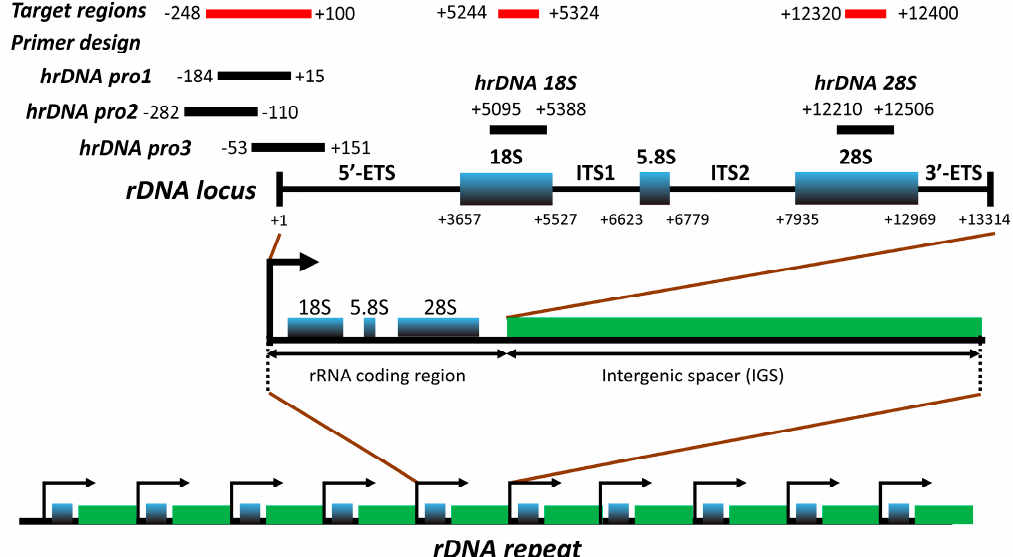
Figure 1. Location of the target regions selected for sequence analysis within the rDNA locus. Base positions are relative to transcription start site ( + 1) of the rRNA gene (rDNA). Each amplicon corresponds to the amplified strand indicated in Table S1. 5’-ETS, 5’ external transcribed spacer; ITS1,